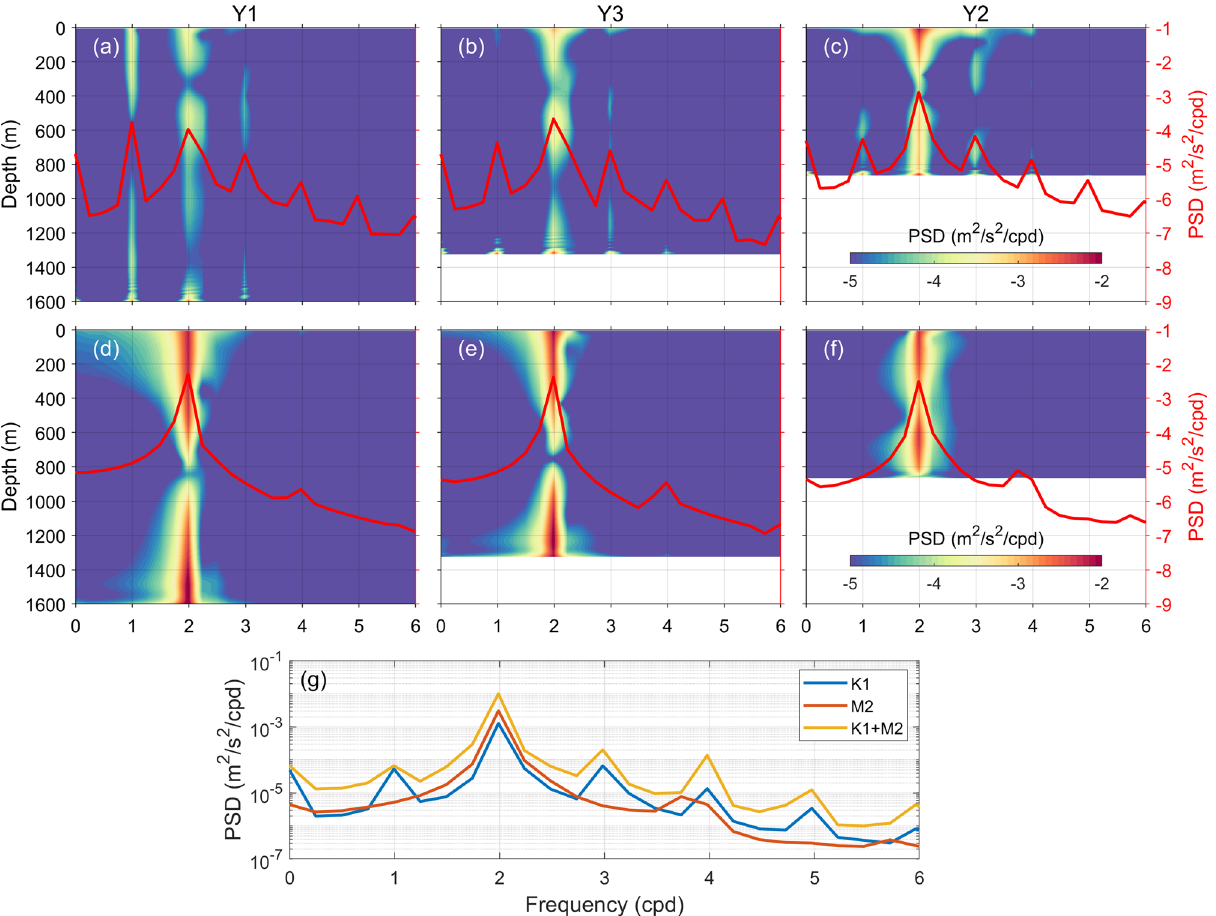
Figure 9. Power spectral densities (PSDs) of cross-isobath baroclinic currents at three mooring position (shading, unit: m 2 /s 2 /cpd) for ( a – c ) K1A ( d – f ) M2A. Depth-averaged PSDs are indicated by red curves in each subfigure. ( g ) Depth-averaged PSDs for different runs at